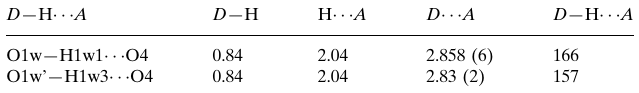
Hydrogen-bond geometry (A˚ , (cid:3)